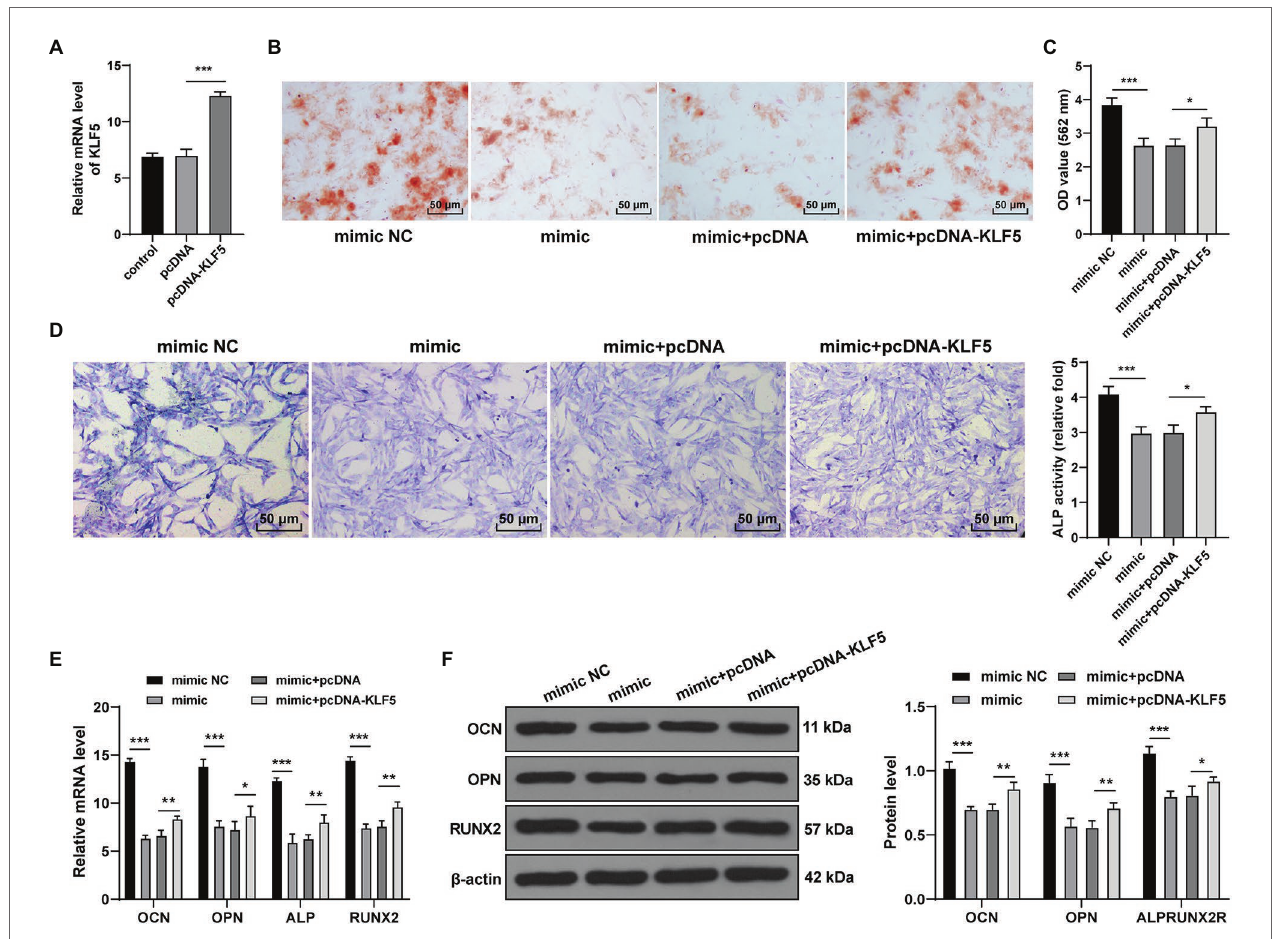
FIGURE 4 | miR-143-3p targeted KLF5 to inhibit osteogenic differentiation of hPDLCs. (A) Effect of pcDNA-KLF5 on KLF5 expression was measured using RT- qPCR. (B,C) Osteogenic differentiation of hPDLCs was measured using ARS staining and ARS semi-quantitative analysis. (D) ALP activity was measured using ALP staining. (E,F) Levels of osteogenic specific markers (OCN, OPN, ALP, and Runx2) were detected using RT-qPCR and Western blotting. The experiment was repeated three times. Data are expressed as mean ± standard deviation. One-way ANOVA was applied to assess data in panels (A,C,D) , and two-way ANOVA was applied to assess data in panels (E,F) , followed by Tukey’s multiple comparisons test, * p < 0.05, ** p < 0.01, *** p <